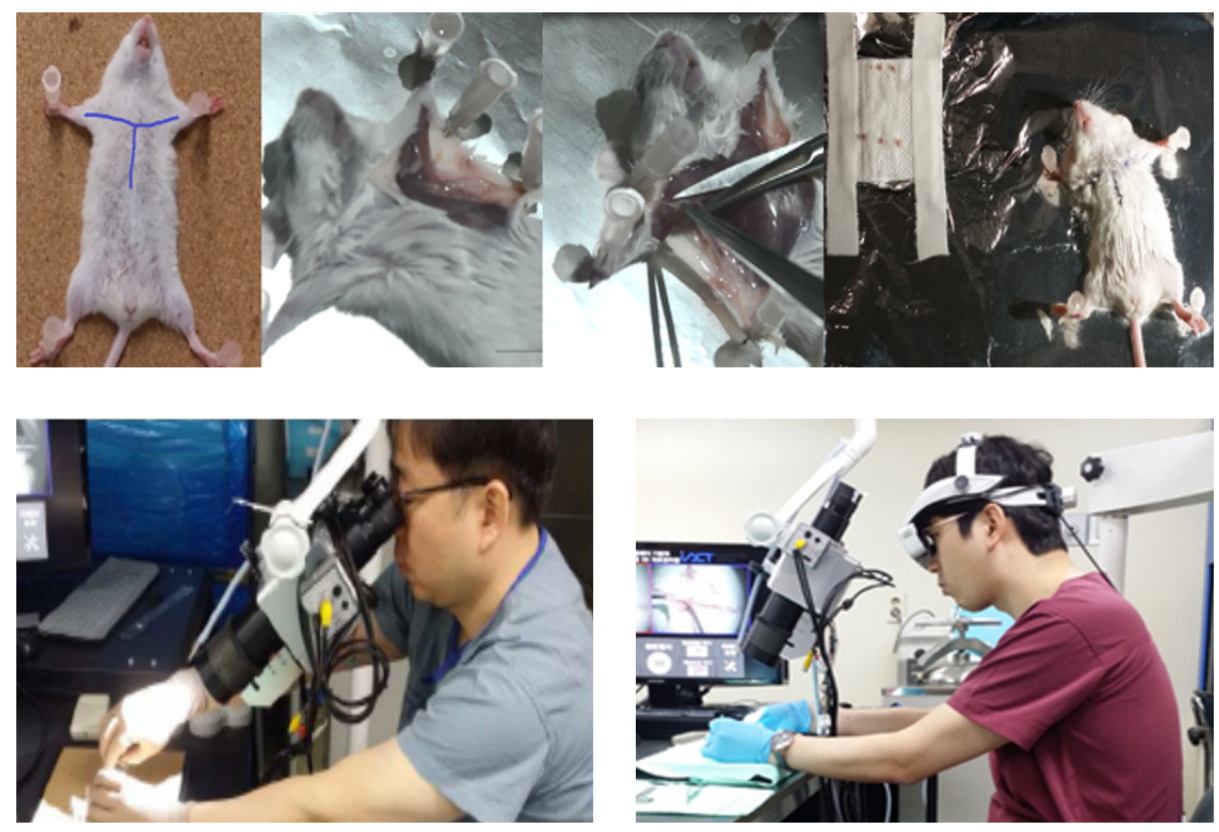
Figure 6. Top: preclinical test of axillary lymph node dissection in white mice; bottom left: preclinical test using eyepieces; bottom right: preclinical test using see-through type 3D head-mounted display.